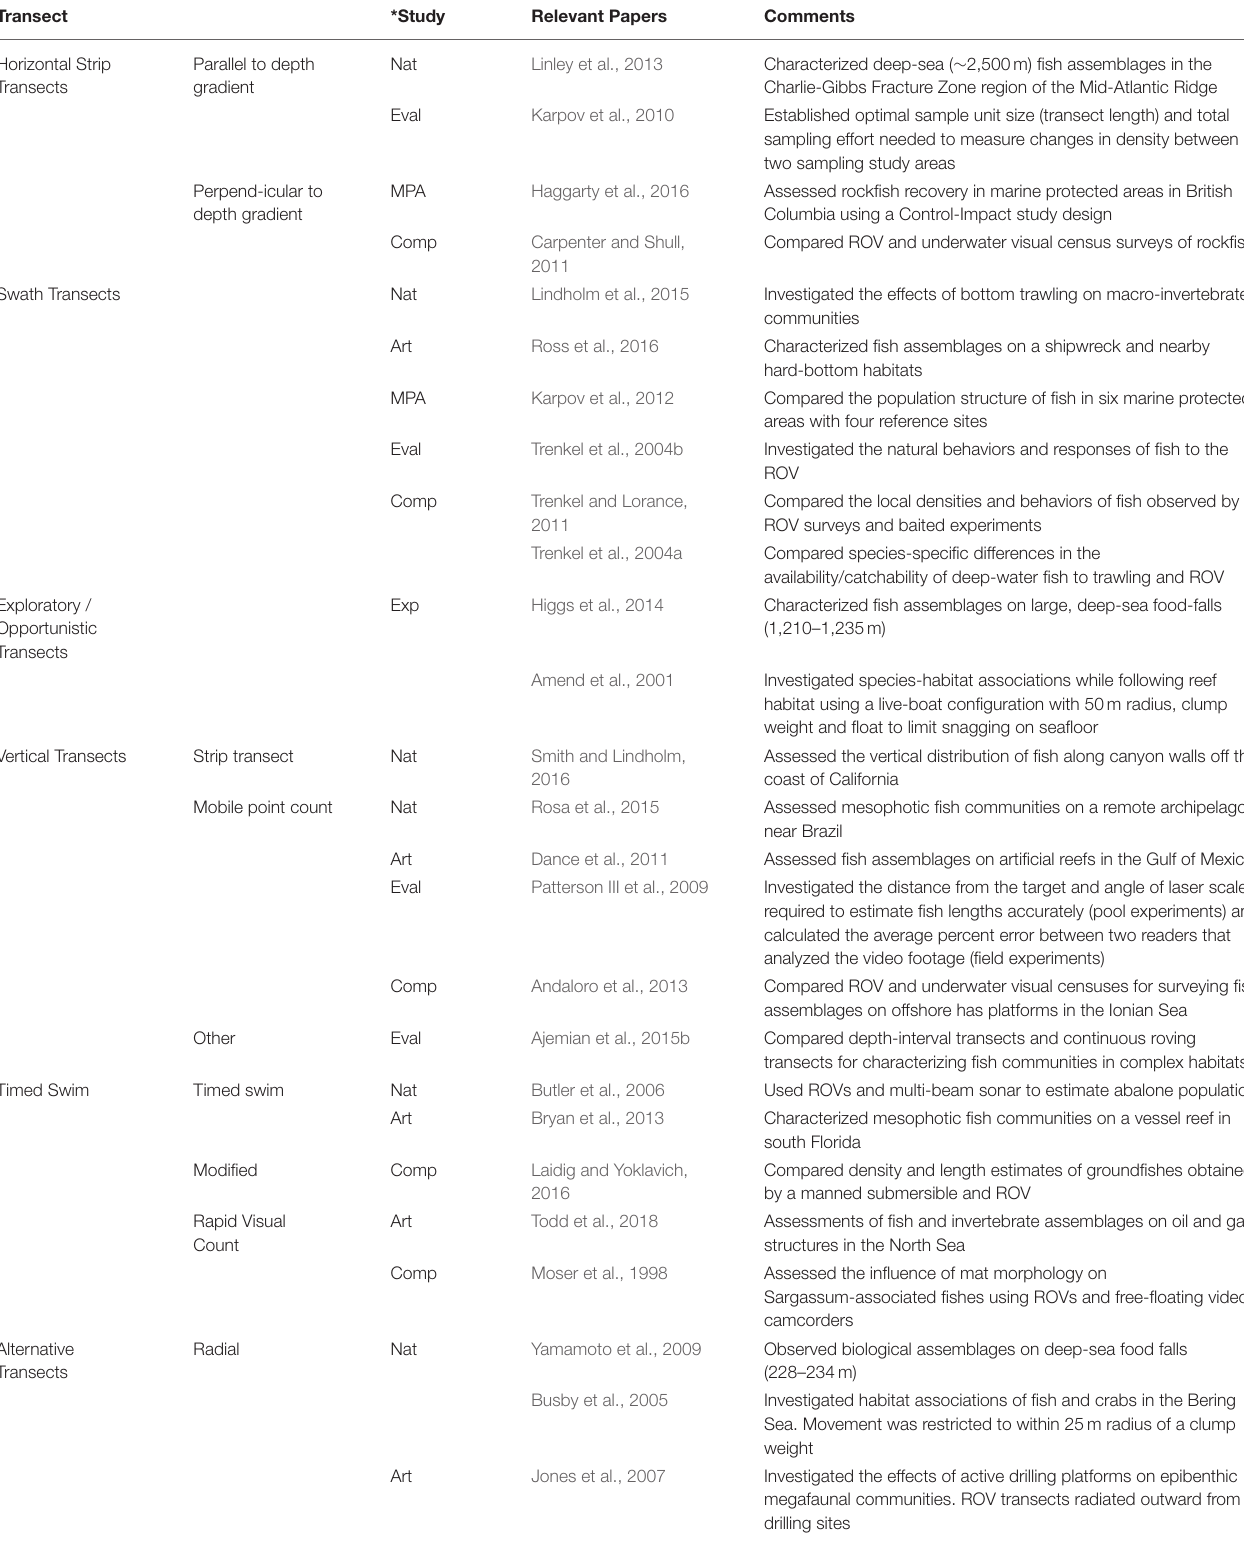
TABLE 3 | Transect designs used in ROV studies to visually survey fish